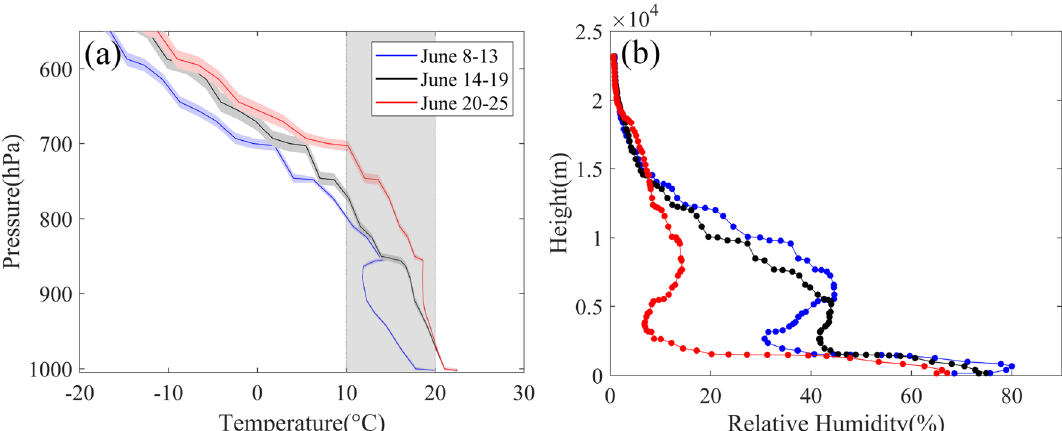
Figure 9. ( a ) Six days composite (day and night average) of pressure–temperature and ( b ) height-relative humidity profile (right) for pre, during the dust storm and post-event from radiosonde datasets for Guimar- Tenerife. The map was generated using MATLAB 2015b, www. mathw orks.